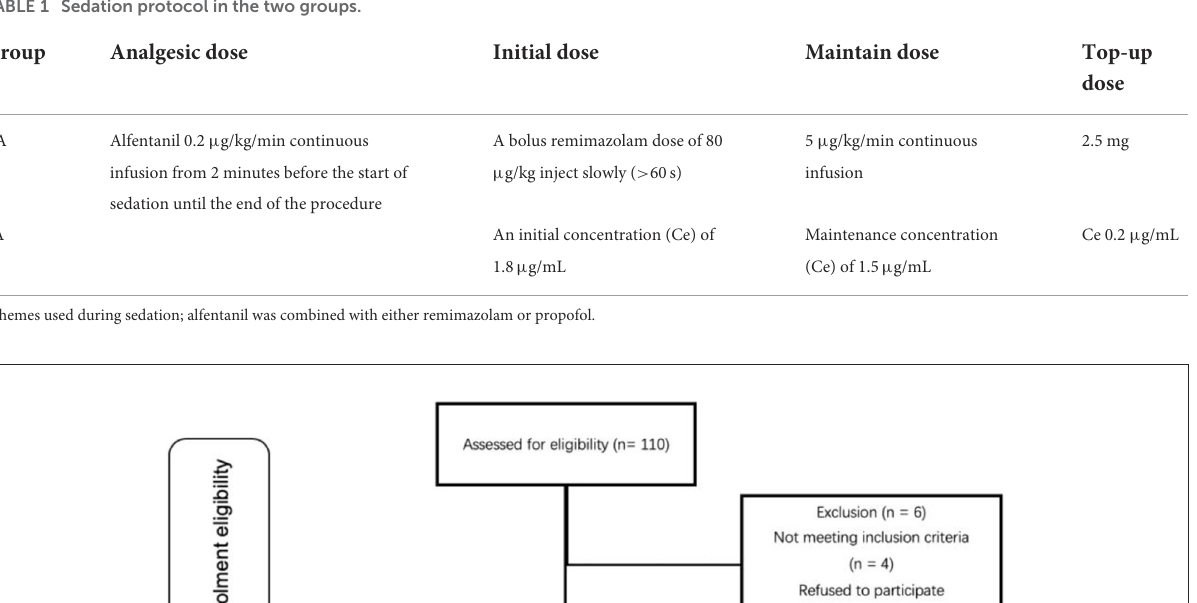
groups. Of these, six were not randomized and four were lost to follow-up, leaving 100 patients available